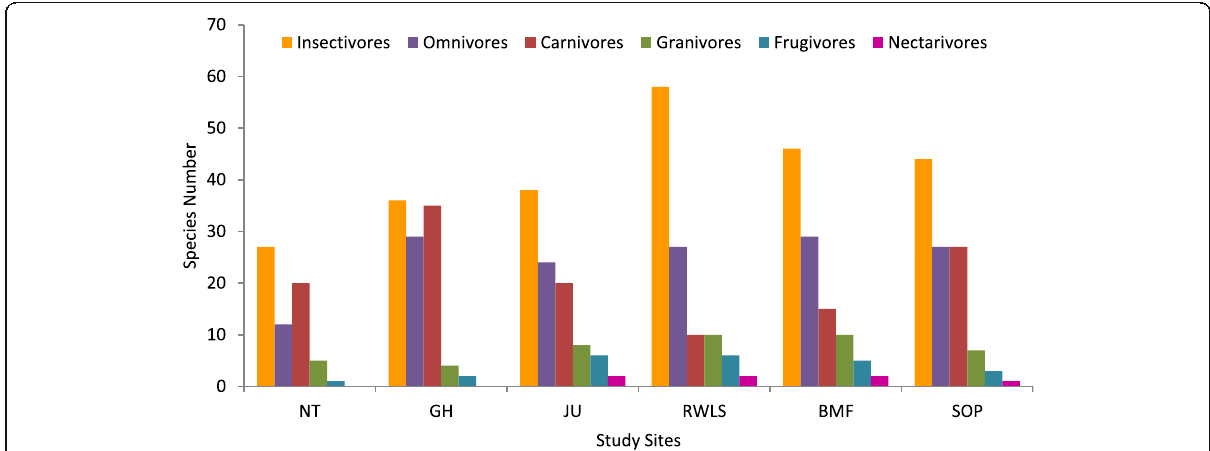
Fig. 4 Bird trophic guilds in the order of dominance. Insectivores and carnivores in aquatic (NT and GWCR); insectivores and omnivores in terrestrial (JU, RWLS, and BMF) and insectivores followed by an equal proportion of omnivores and carnivores in Southern Open Plains (SOP), the mixed